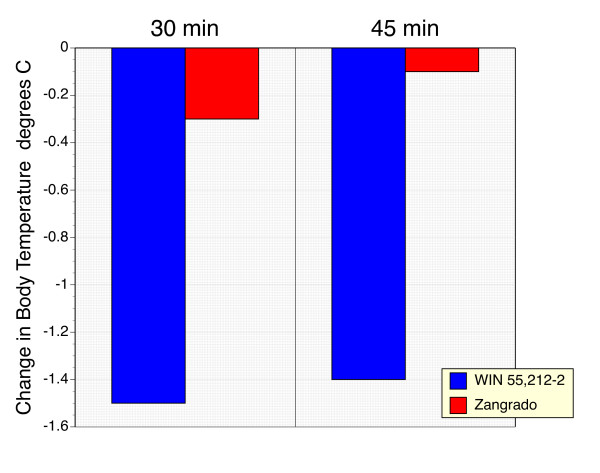
Comparison of the cannabinoid receptor agonist, WIN 55,212-2 and Zangrado on body temperature in ferrets. Ferrets treated with the CB1 receptor agonist, WIN 55,212-2 (1 mg/kg, ip) displayed a substantial reduction in body temperature when measured at 30 and 45 minutes after administration. In contrast, there was no effect of Zangrado (3 mg/kg, ip) on body temperature (n = 6, p < 0.05). Both agents were administered at effective anti-emetic doses.